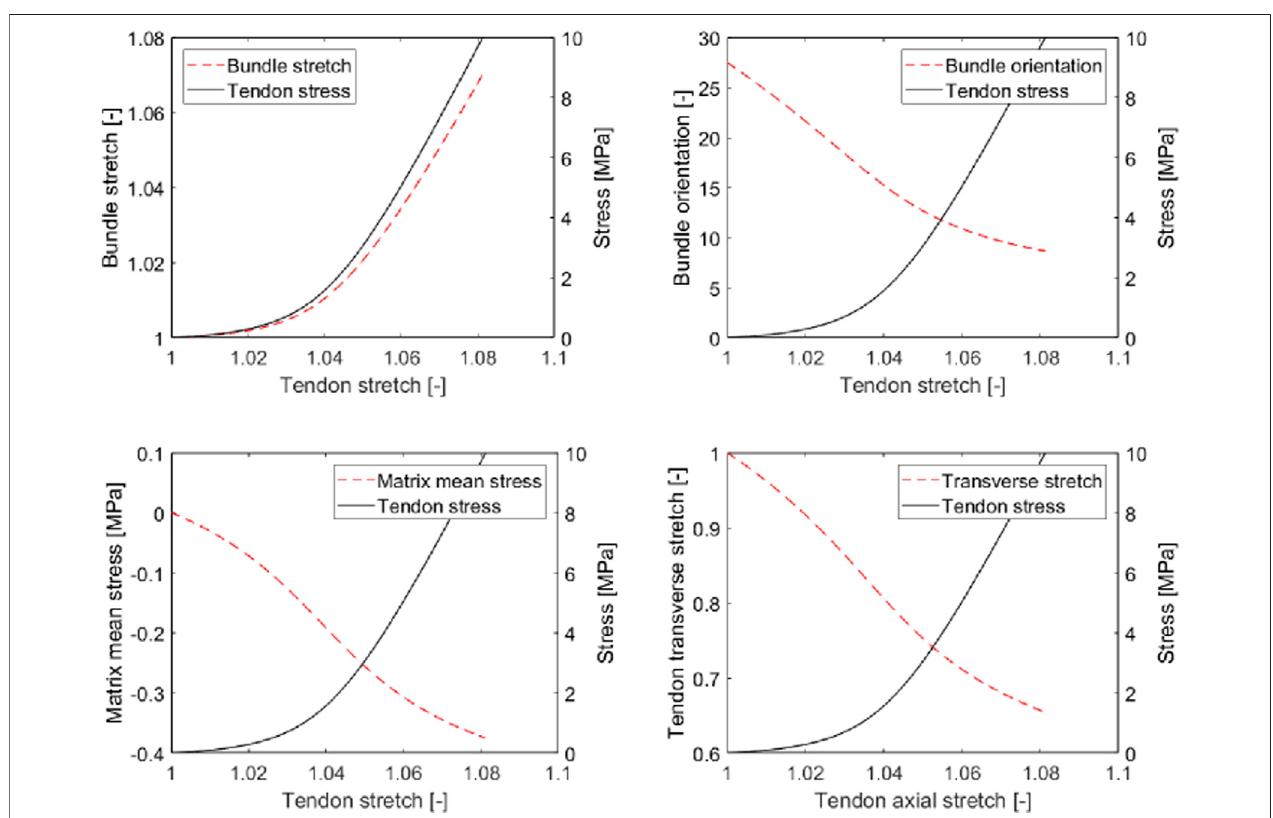
FIGURE 9 | Micromechanical model predictions for tendinous tissue subjected to uniaxial tension: axial stretch in collagen bundle (top left) , latitudinal angle of collagenbundle (topright) , meanstressininterfascicular matrix (bottomleft) , and transverse stretchintendinoustissue (bottom right) , asfunctions ofaxialstretch in tendinous